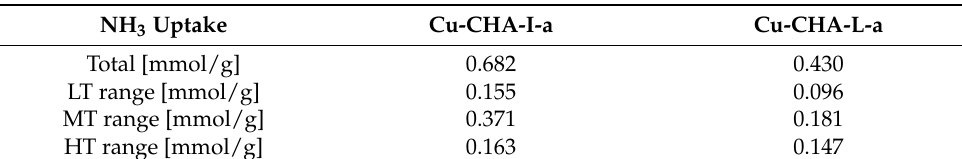
Figure 2. TEM bright field images (TEM-BF, ( a , c )) for reference and corresponding Z-contrast images (( b , d ), false colored) of Cu-CHA-L-a ( a , b ) and Cu-CHA-I-a ( c , d ). Z-contrast images show enlarged regions marked by the reticule in ( a , c ). Example specks of CuO x (particle size 4–6 nm) residing on CHA-material are marked with white pointers. Table 2. NH 3 uptake derived by deconvolution of the NH 3 -TPD profile in the low, mid and high temperature ranges (LT, MT and HT, respectively).